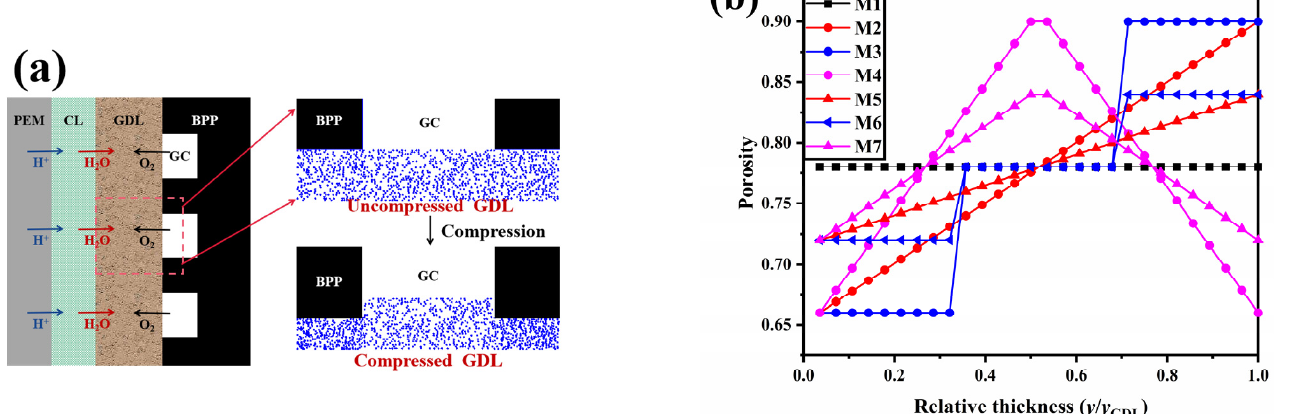
Figure 2. ( a ) Schematic diagram of the computational domain and ( b ) porosity